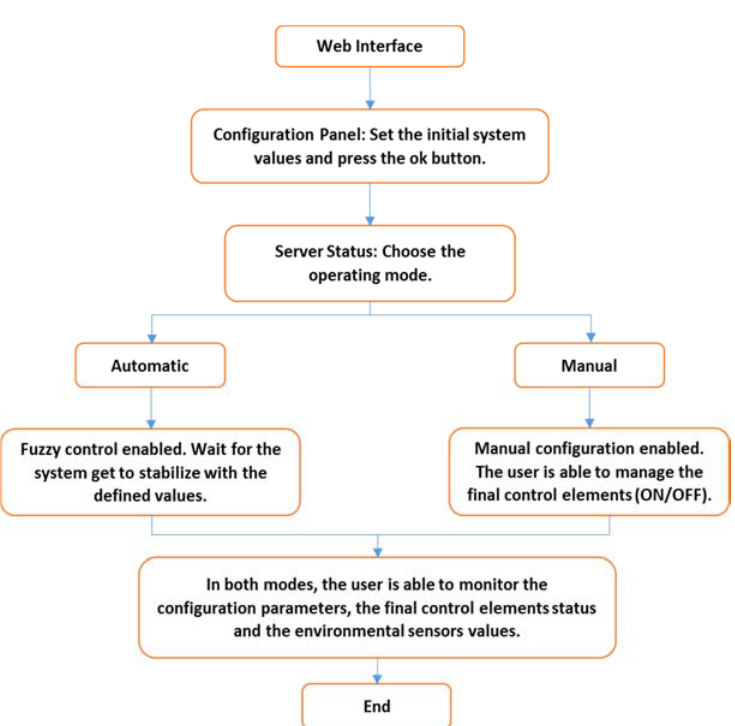
Figure 8. Flowchart for the web interface.